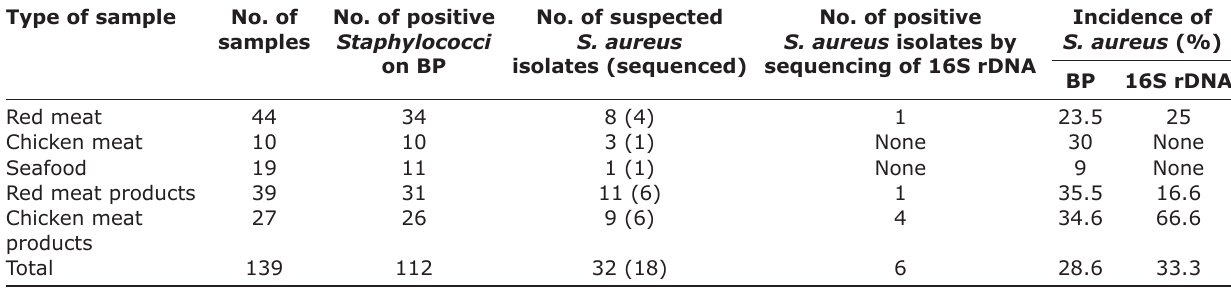
Table-3: Comparison between conventional and molecular identification of suspected S. aureus in different meat, meat products, and some seafood samples. Type of sample